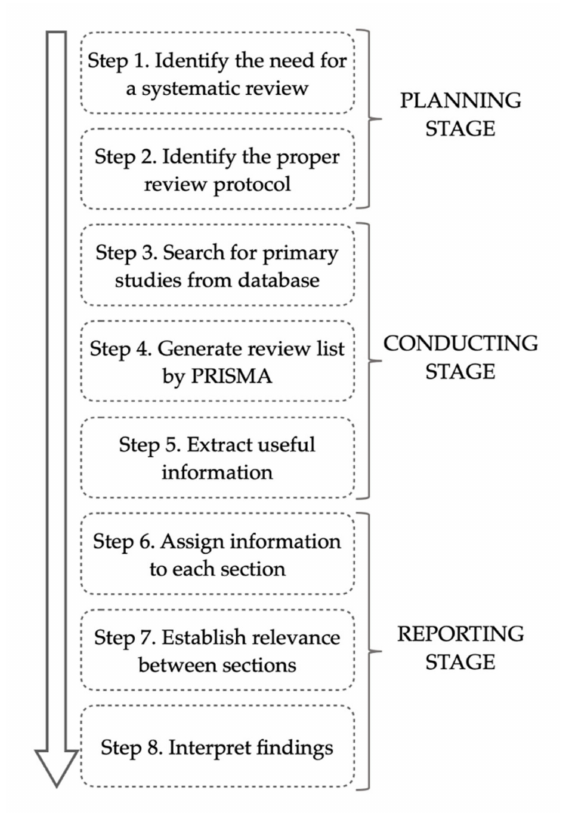
Figure 1. Research steps for the literature